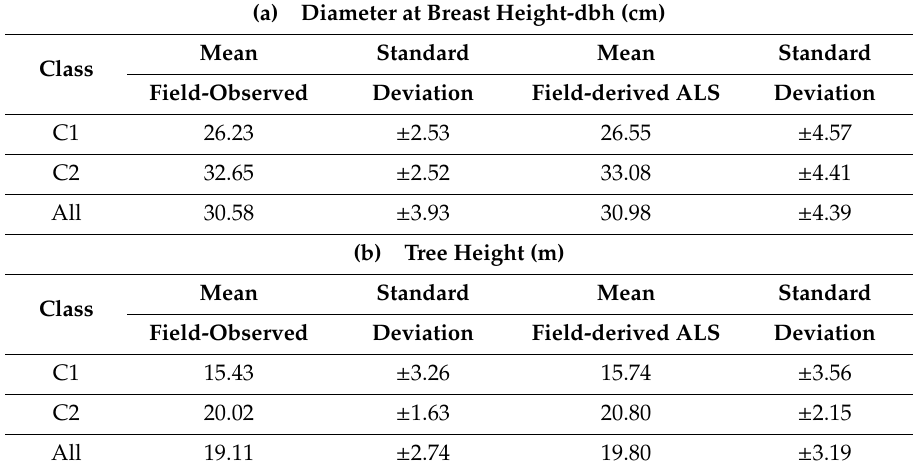
Figure 6. Example of stem segmentation for dbh measurement from the UAV-lidar 3D point cloud (white dots). ( a ) Error in measurement; ( b ) correct measurement. Table 1. Summary of the relationship between (a) field observed dbh and UAV-lidar derived dbh; (b) field observed tree total height and UAV-lidar total height derived in the integrated crop-livestock-forest system (ICLF) in